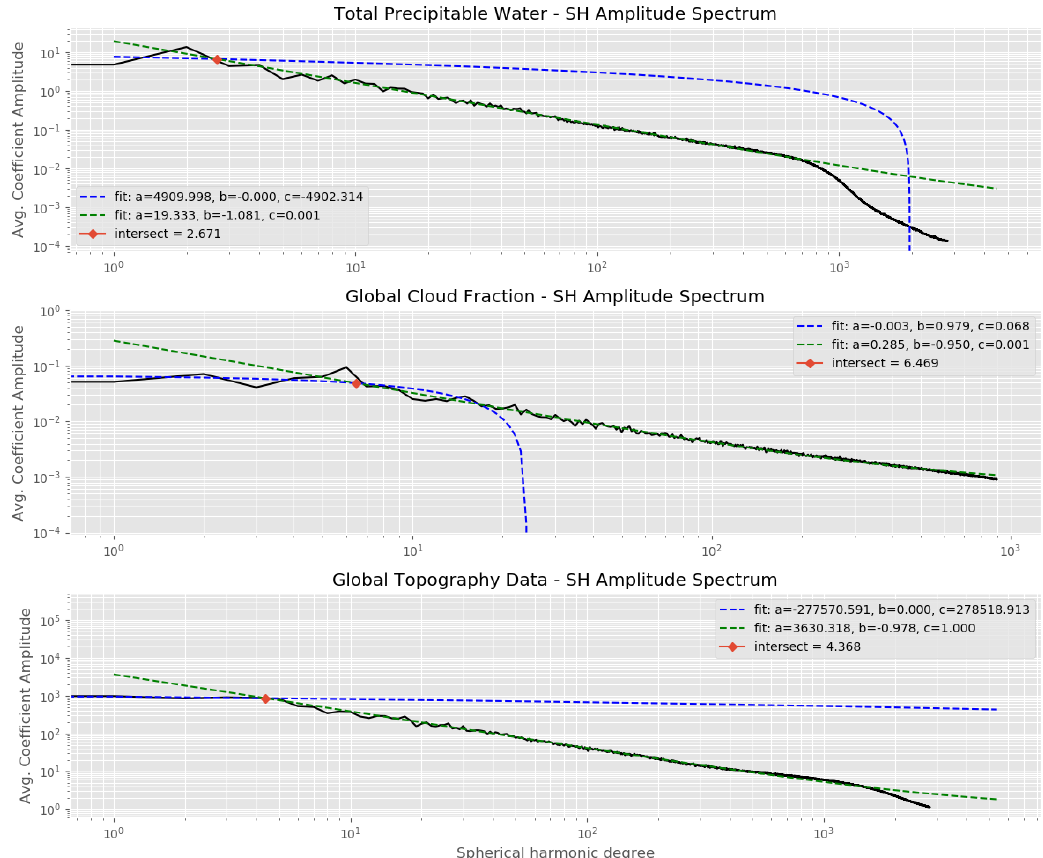
Figure 4. 1D averaged spatial amplitude spectrum for real data fields based on composite satellite observations. Fit coefficients over two branches (dotted blue and green lines) correspond to a function f = ax b + c , where x is the logarithm of the spherical harmonic